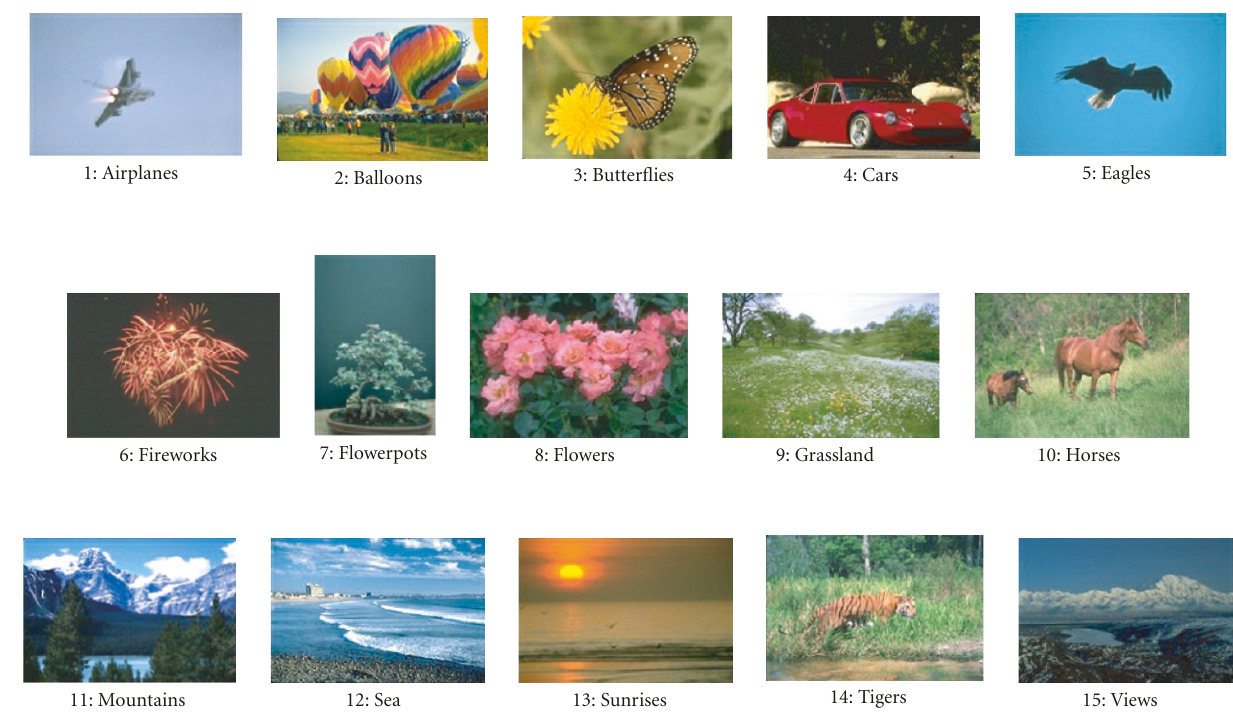
Figure 2: The selected class